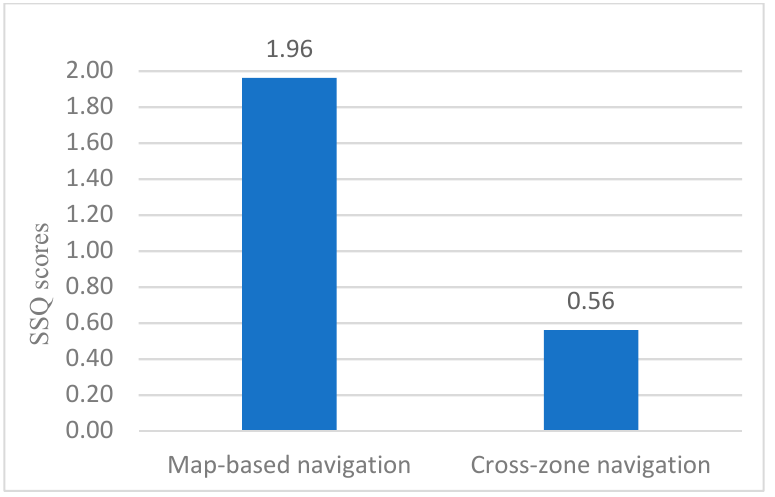
Figure 8. SSQ scores for map-based navigation and cross-zone navigation groups.